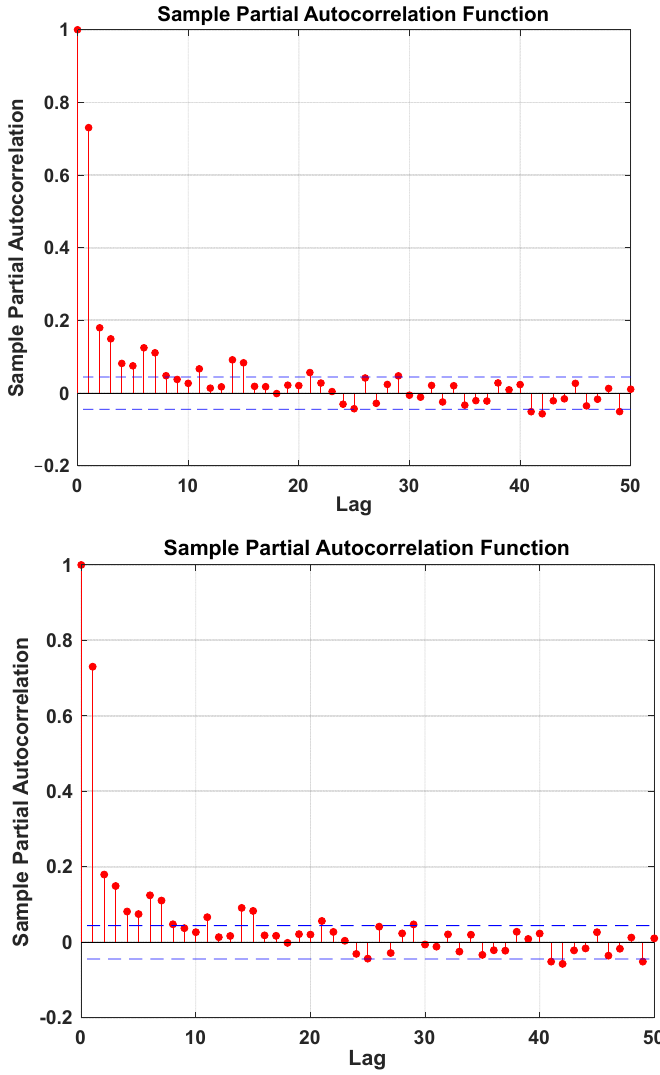
Figure 12. Sample partial autocorrelation functions of the lagged ET 0 time series at Ishurdi station. Five Bi-LSTM models were developed to forecast 1, 2, 3, 4, and 5 day-ahead ET 0 forecasting. For all models, the selected time-lagged variables were served as inputs to the Bi-